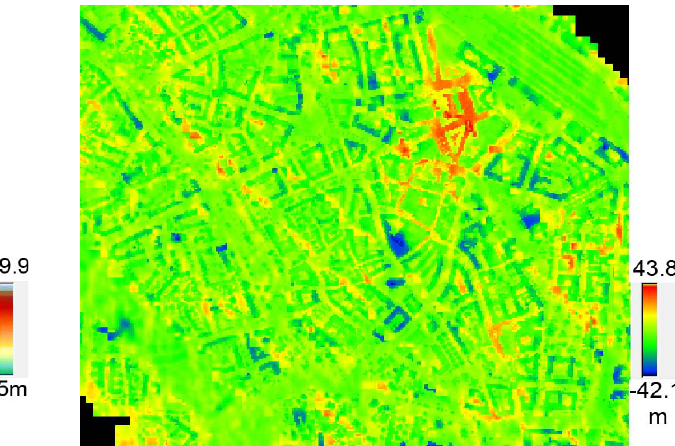
Fig. 5: LIDAR DSM Fig. 6: Difference LIDAR DSM – CoSSC DSM